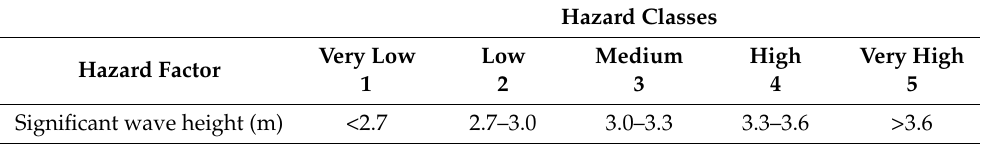
Table 9. Hazard classification concerning the significant wave height hazard subfactor.